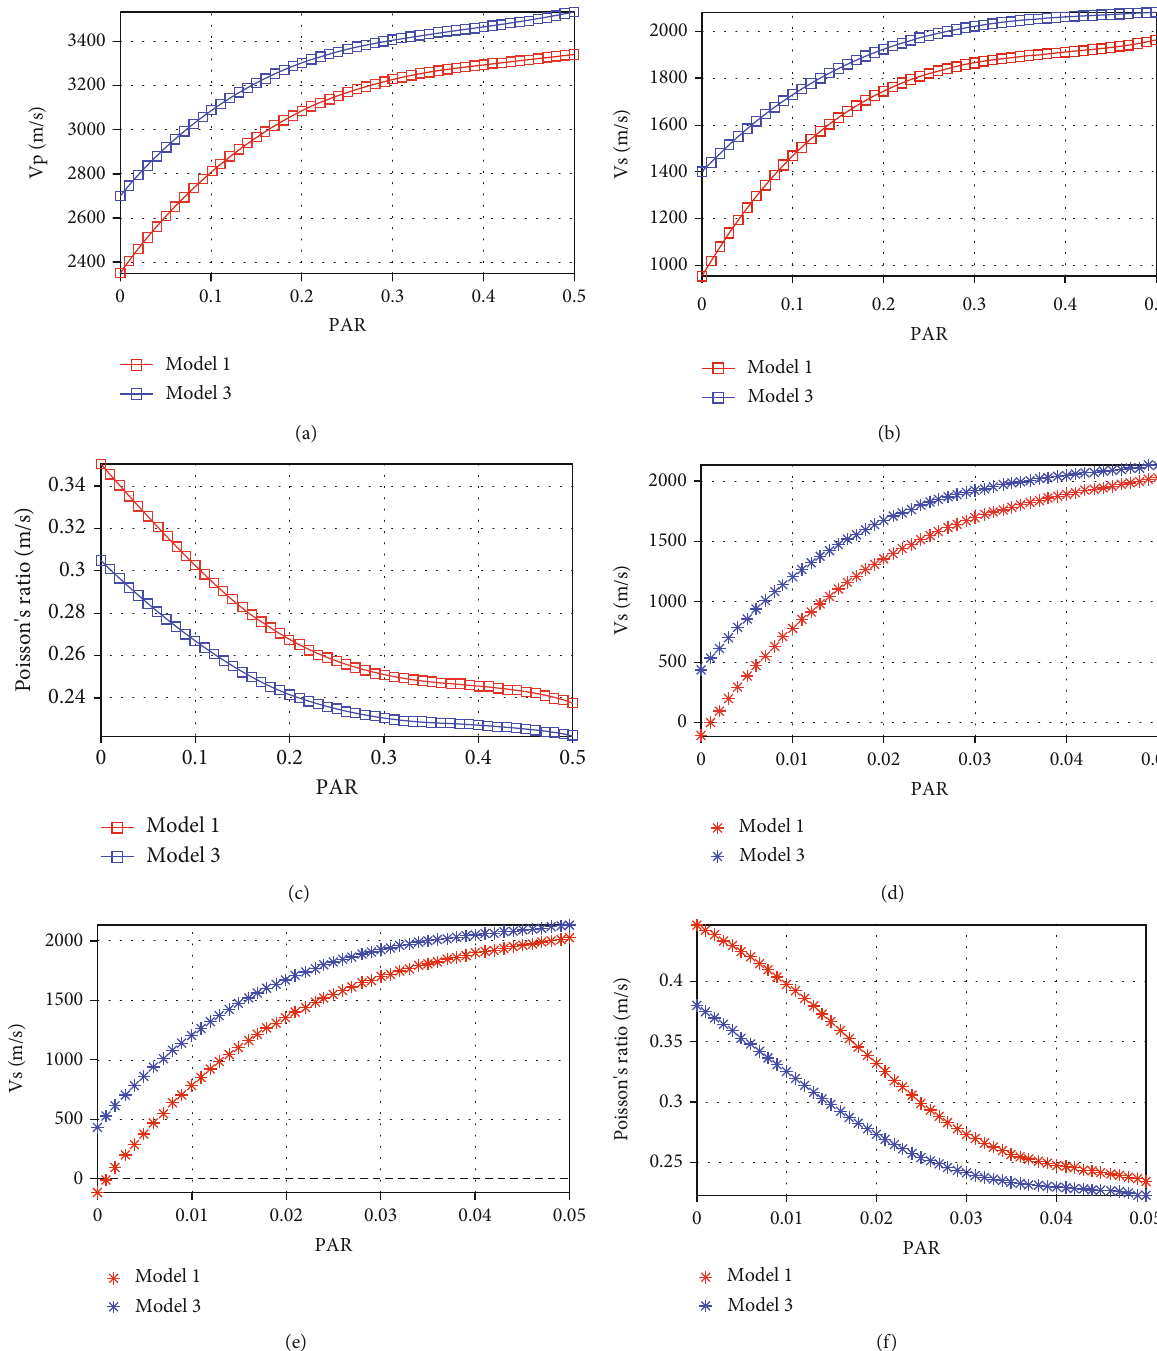
Figure 10: The relationships between the pore aspect ratio and rock physical elastic parameters; Model 1 is a pore- fi lling model, and Model 3 is a particle cementation model. (a) Relationship between V and PAR of spherical pores; (b) relationship between V p spherical pores; (c) relationship between Poisson ’ s ratio and PAR of spherical pores; (d) relationship between V shaped cracks; (e) relationship between V and PAR of penny-shaped cracks; (f) relationship between Poisson ’ s ratio and PAR of penny- s shaped